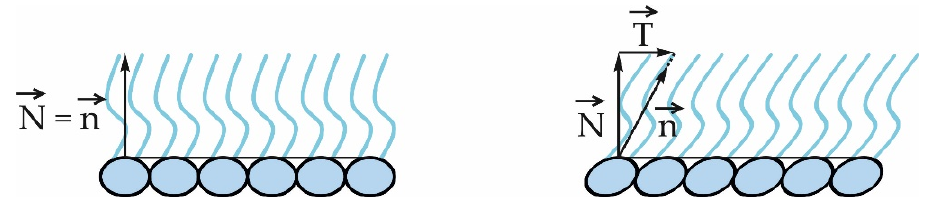
Figure 2. Definition of the vector fields n , N and T . On the left-hand side, the lipid monolayer is in the reference state, and the directions of the normal N to the monolayer and director n , which characterizes the mean orientation of lipid tails, coincide. On the right-hand side, the monolayer is tilted, and the tilt vector T represents the degree of deviation of n from N